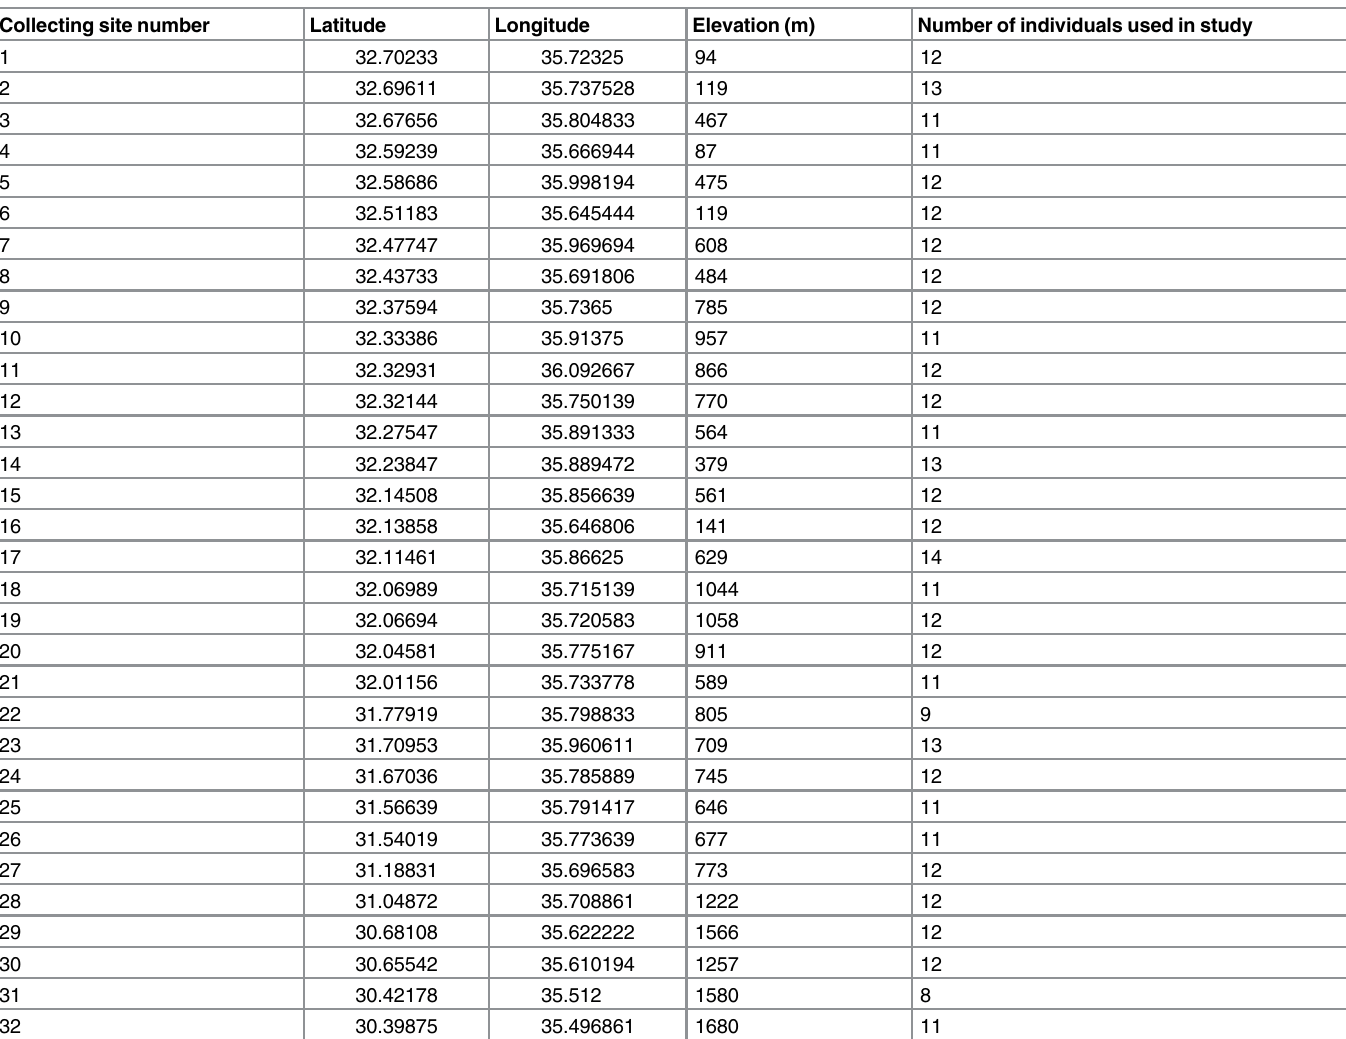
Table 1. Collecting site